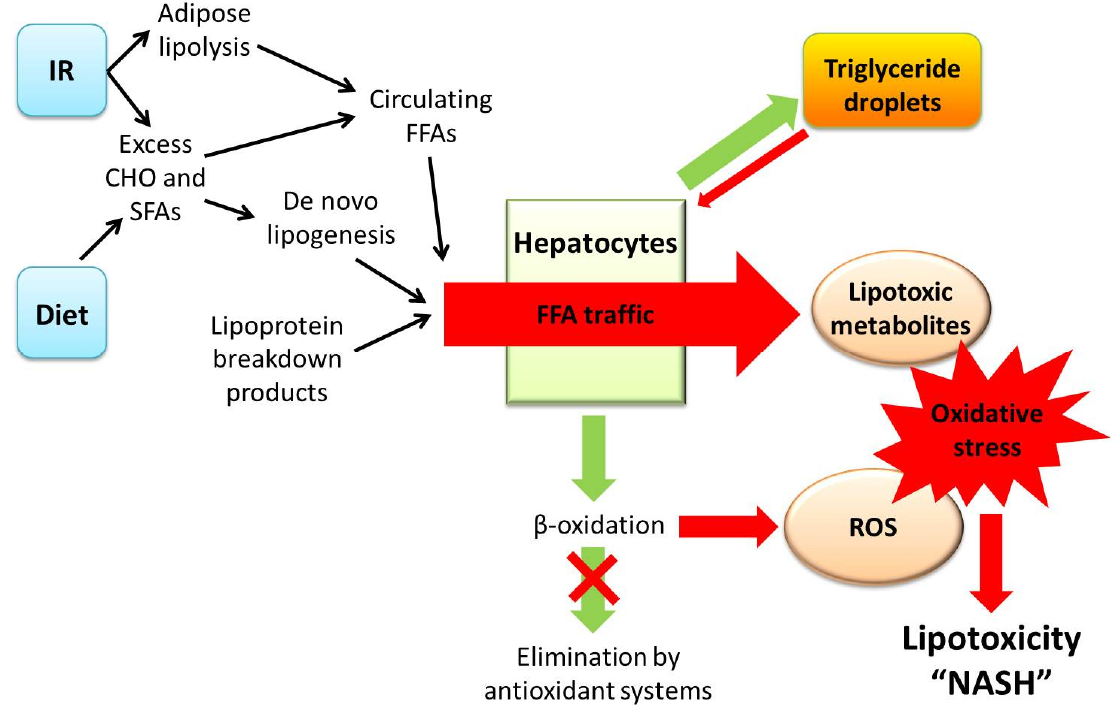
Figure 1. The lipotoxicity model of pathogenesis in non-alcoholic steatohepatitis (NASH). In the setting of established insulin resistance (IR) and a diet high in saturated fats, hepatic traffic of excess free fatty acids (FFA) induces hepatocyte injury via lipotoxicity, caused by oxidative stress through the generation of lipotoxic metabolites (such as ceramides, diacylglycerols, and lysophosphatidyl choline) and reactive oxygen species (ROS). Protective mechanisms are shown as green arrows and injurious mechanisms are shown as red arrows. In the current model, the accumulation of triglyceride within hepatocytes likely represents a protective adaptation to excess FFA traffic, with only a minor contribution to the toxic effects of FFA flux via autophagy. (In the previous model of pathogenesis, the accumulation of hepatocyte triglyceride (“steatosis”) was considered a pre-requisite for oxidative stress, whereas emerging data suggest that steatosis occurs in parallel with lipotoxicity). A diet high in carbohydrates (CHO) and saturated fatty acids (SFAs) contributes to the production of excess FFA, as does the development of insulin resistance. In the chronic disease state, safe disposal of FFA via beta-oxidation and cellular antioxidant systems is overwhelmed resulting in the accumulation of excess ROS and subsequent oxidative stress, which results in NASH (Adapted from Hepatology 2010, 52 , 774–788)